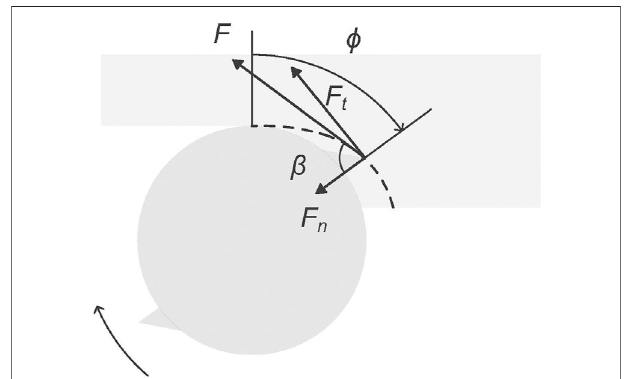
FIGURE 1 | Geometrical representation of the forces simulated by the physics-based model. F is the cutting force and β is the force angle. F t and F n denote the tangential and the normal cutting forces and ϕ is the cutting tooth angle.